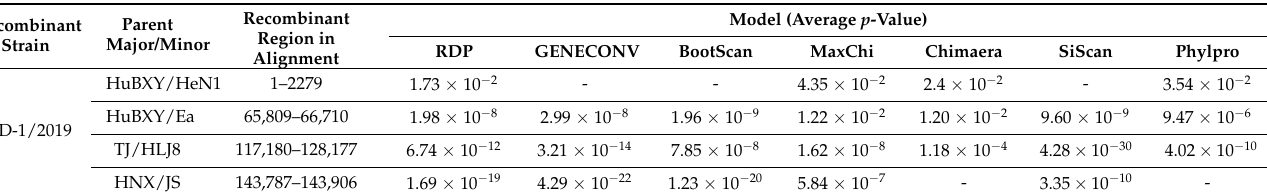
Table 3. Algorithms of the RDP4 package used to predict the recombination event.